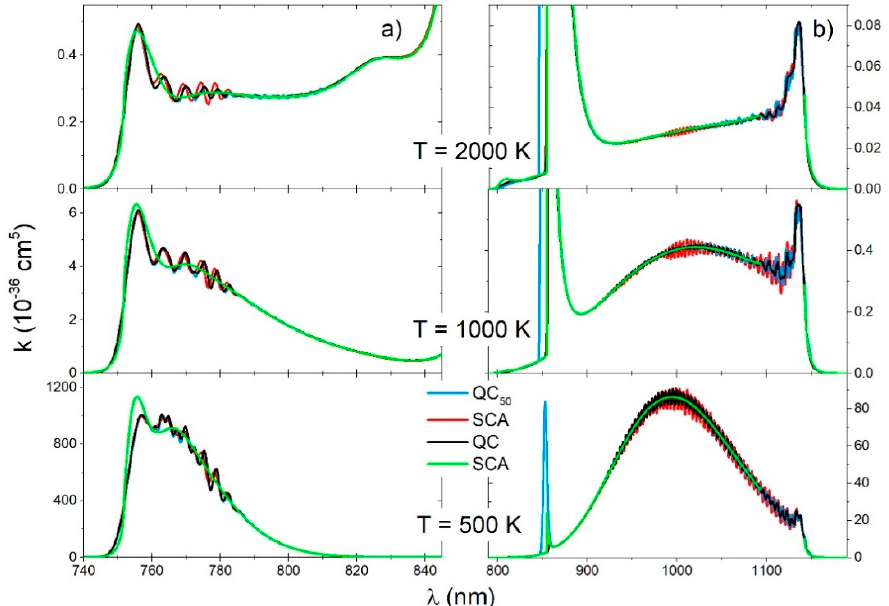
Figure 8. Cs 2 molecule, ( a ) reduced absorption coefficient for the B 1 Π u ( 1 u ) → X 1 Σ + g ( 0 + g ) and ( b ) A 1 Σ + u ( 0 + u ) → X 1 Σ + g ( 0 + g ) transitions for three different temperatures (2000 K, 1000 K, 500 K), obtained with four theoretical approaches (SQA, QC 50 , QC, SCA).